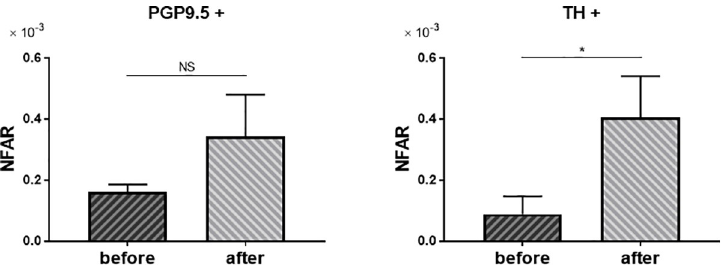
Fig 6. Change of NFAR after antiviral treatment. Comparison of NFAR for whole nerve fibers (PGP9.5+) and sympathetic nerve fiber (TH+). Before antiviral treatment vs. after treatment. Data were analyzed by unpaired t test. NS: not significant. � P = 0.02.